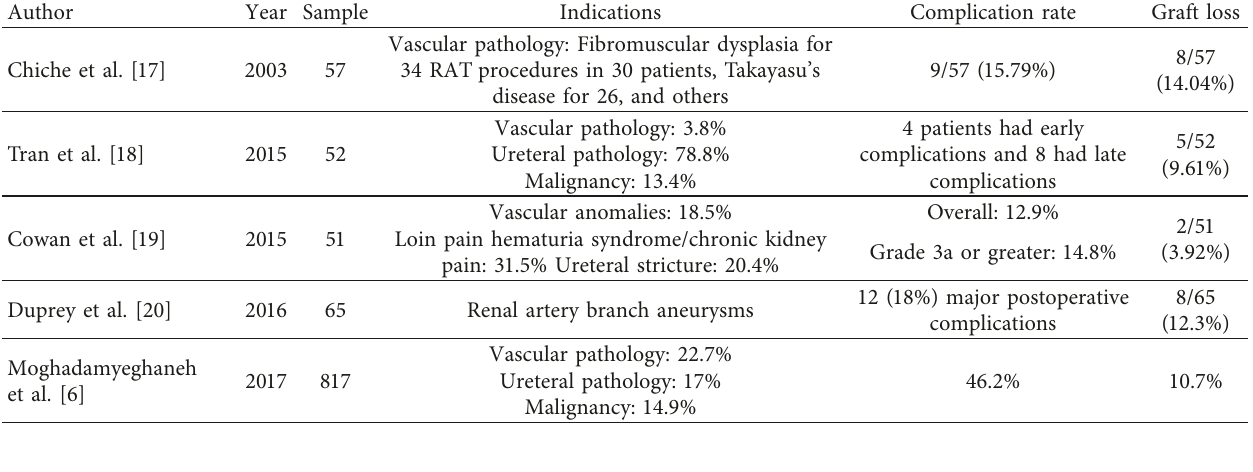
Table 11: Largest published series of KAT.